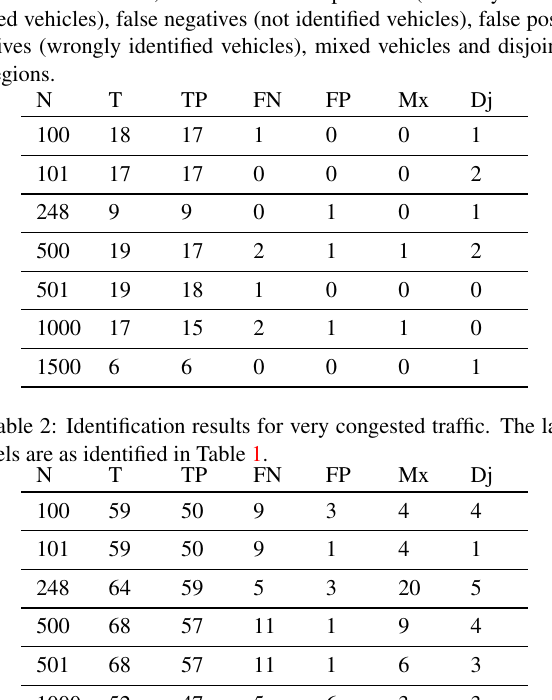
Table 1: Identification results for smoothly flowing traffic. N, T, TP, FN, Mx and Dj are respectively the image number, the total number of vehicles, the number of true positives (correctly identi-